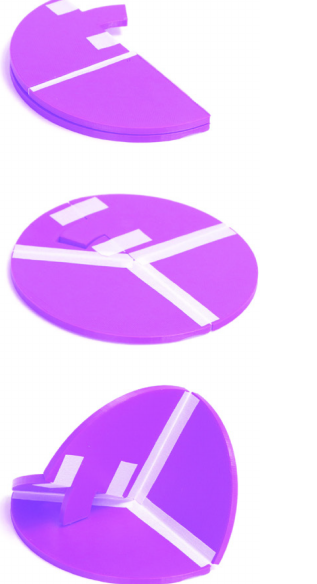
Figure 24. Flat-foldable sector panel ThUDS with flat foldability in the same direction as deployment. Shown in flat-folded, flat, and deployed states.